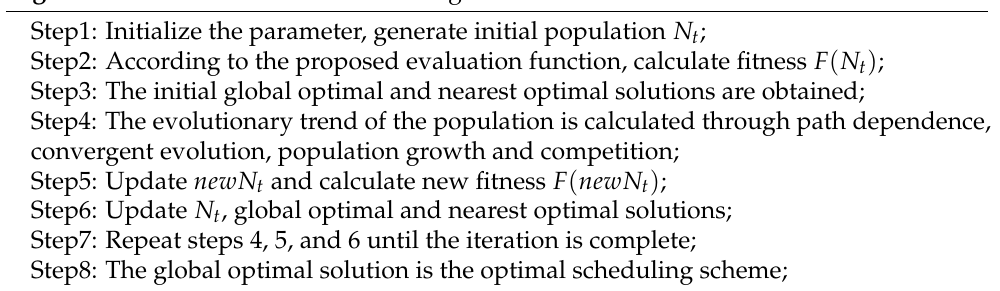
Algorithm 3 APPE based task